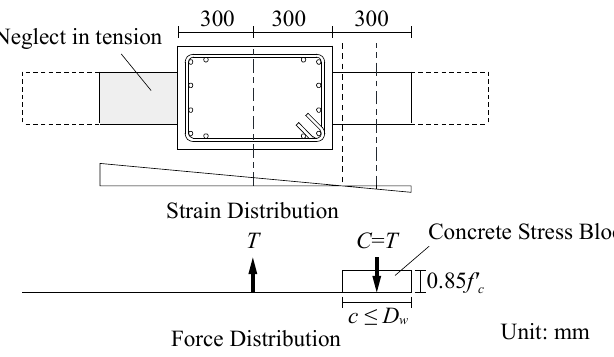
Figure 14. Schematic diagram of the forces on the cross-section.